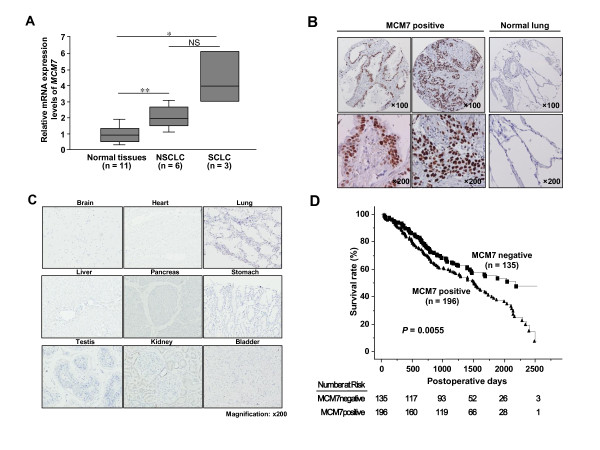
Dysregulation of MCM7 in lung cancer tissues, and correlation of MCM7 expression to a negative outcome for NSCLC patients after surgical operation. (A) Overexpression of MCM7 in clinical lung cancer tissues [NSCLC (n = 6) and SCLC (n = 3)] compared with several normal tissues (lung, brain, colon, esophagus, eye, heart, liver, rectum, stomach, bladder and kidney) analyzed by quantitative real-time PCR. Statistical analysis was done using Kruskal-Wallis test; P < 0.0001: Mann Whitney U-test; *, P < 0.05; NS, not significant (P = 0.0528). (B) Representative cases for positive MCM7 expression in lung ADC, SCC tissues and normal lung tissues. Original magnification, ×100 and ×200. (C) Immunohistochemical analysis of MCM7 in various normal tissues. No significant staining was observed. Characteristics of each tissue were described in Additional file 12. (D) Kaplan-Meier estimates of overall survival time of patients with NSCLC (P = 0.0055, log-rank test).